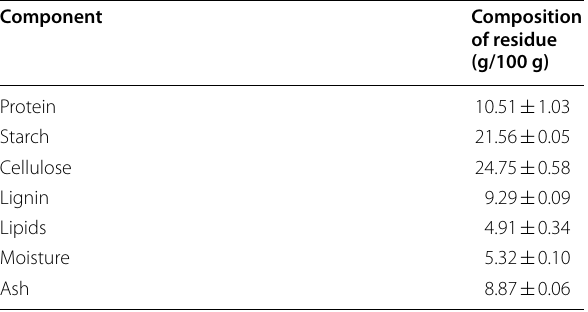
Table 8 Composition of the residue from enzymatic